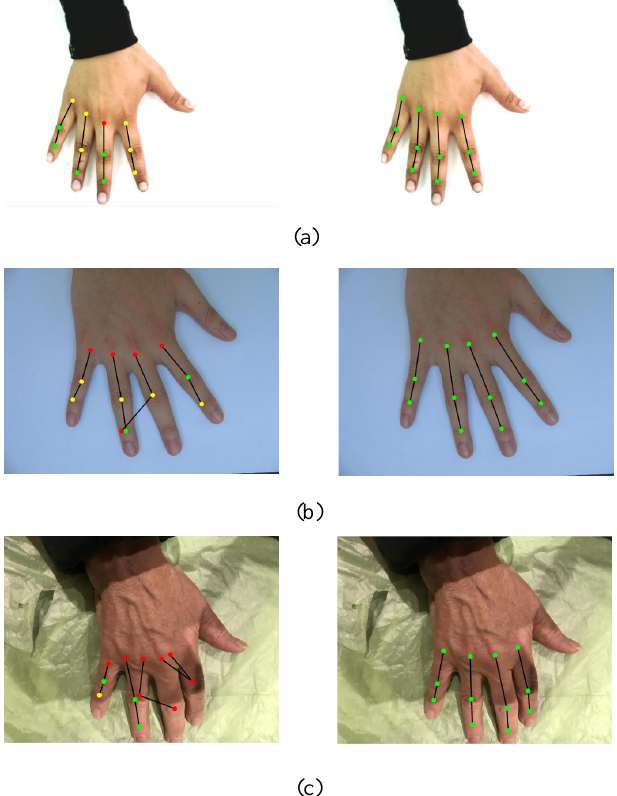
Figure 5. Samples showing finger skeletonization; Left column: Openpose; Right column: WBF; ( a ) 11k, ( b ) HD, and ( c ) HUQ dataset. Different colored markers correspond to different types of keypoints: Green: Falling within QBB; Yellow: Falling outside QBB but within FBB; and Red: Falling outside FBB (only knuckle keypoints are shown for Openpose) (refer to the web version for